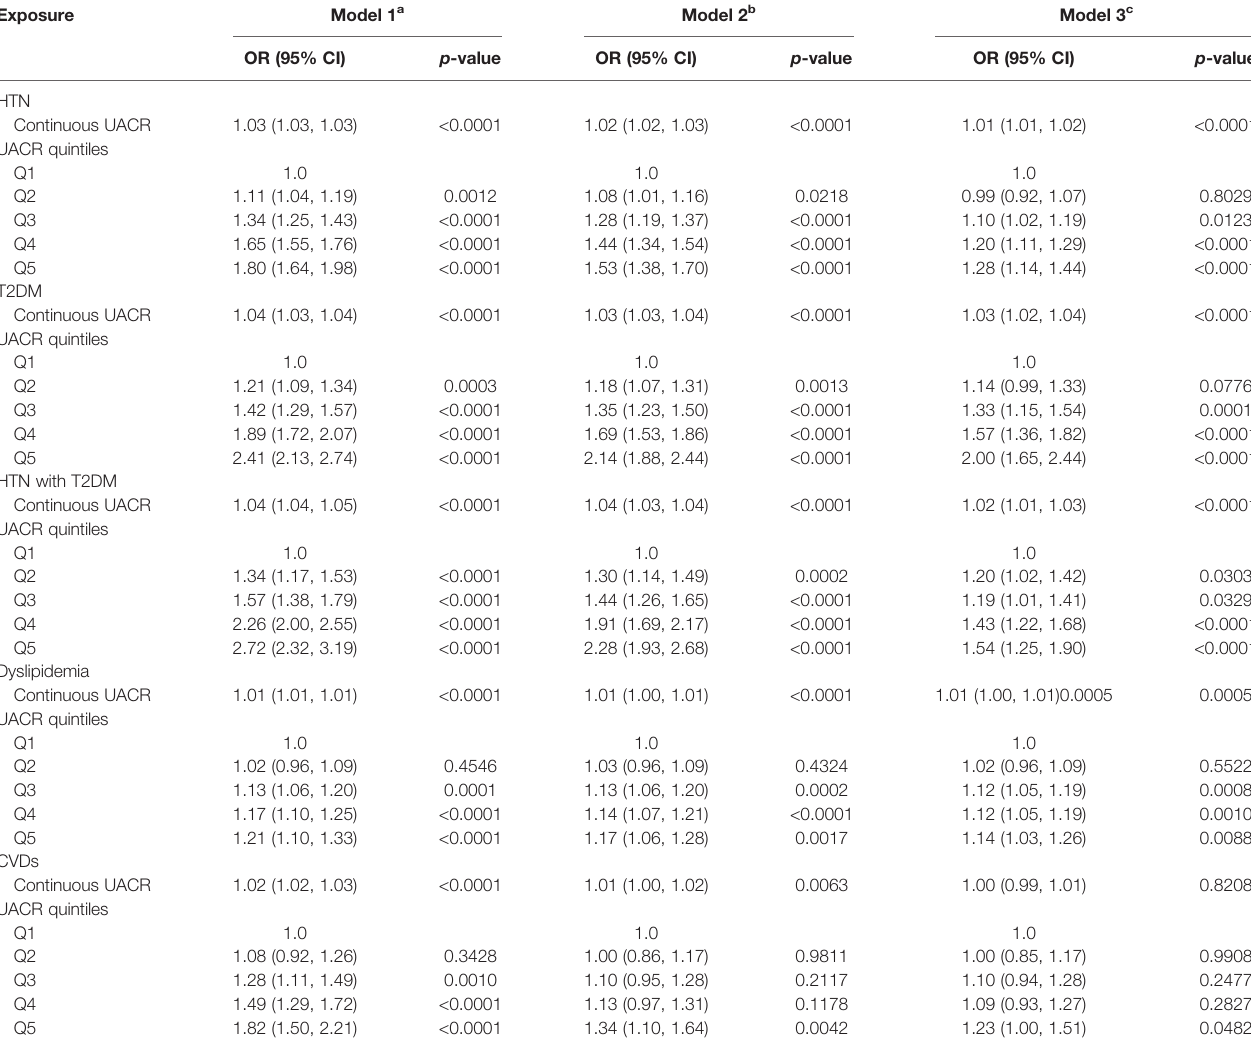
TABLE 3 | Associations of UACR with HTN, T2DM, HTN with T2DM, dyslipidemia, and CVDs in participants with normal UACR (<30 mg/g).